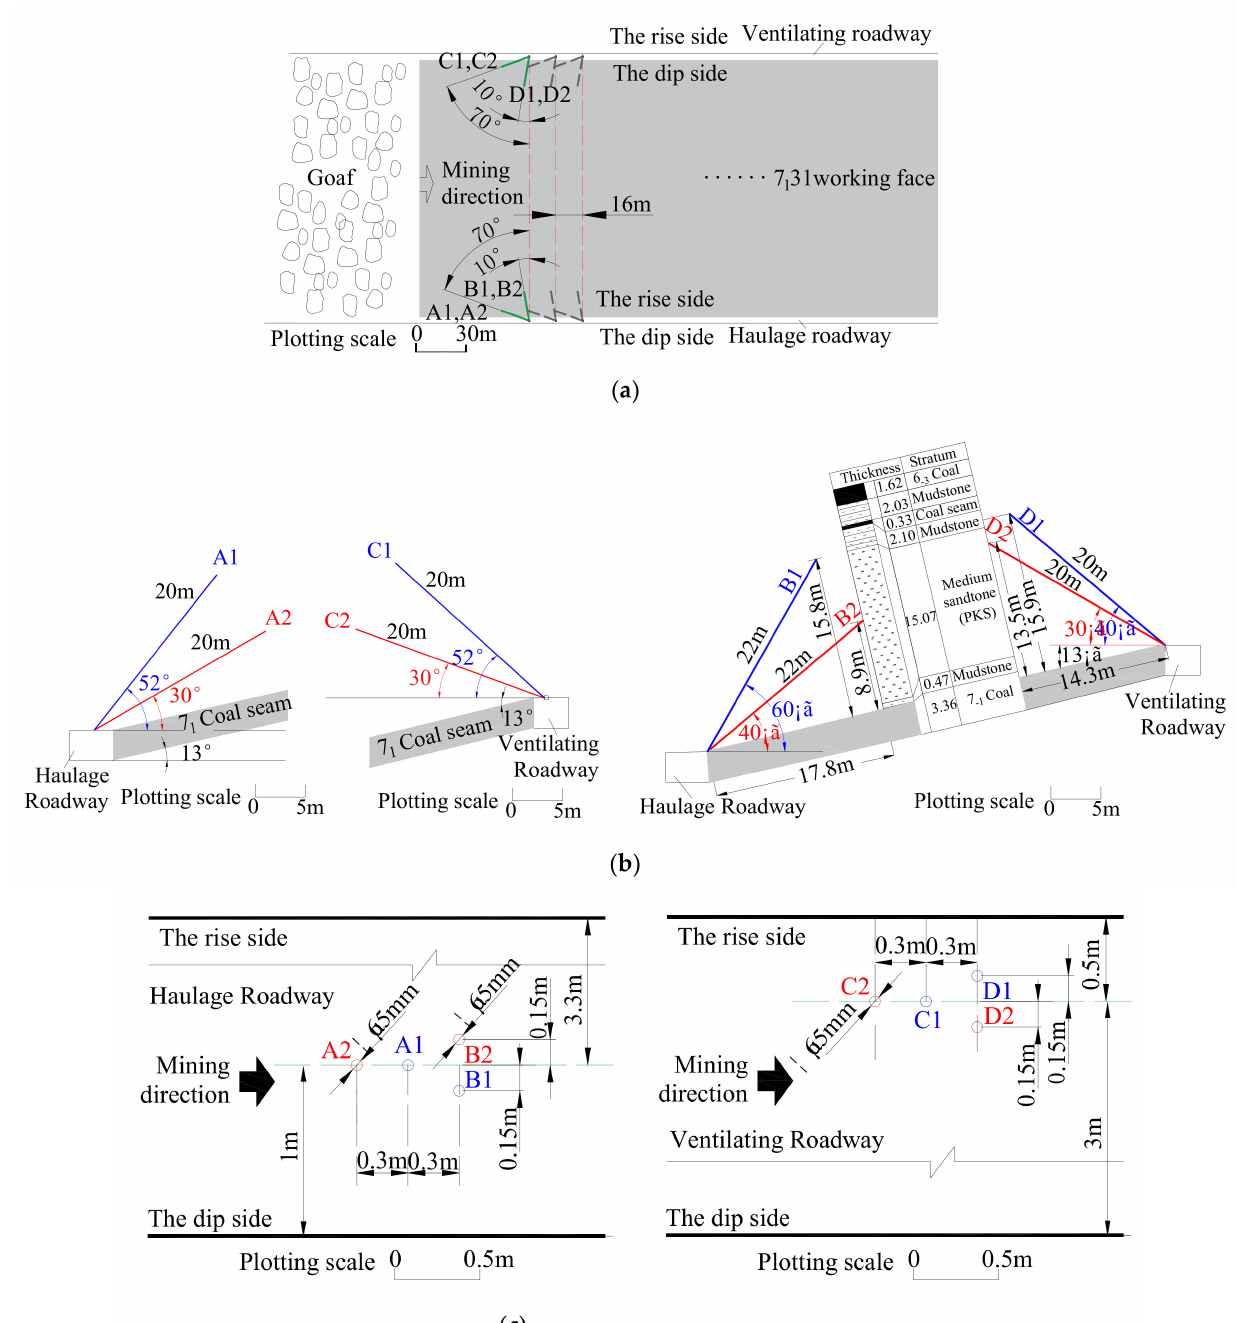
Figure 14. Design scheme of roof pre-split blasting: ( a ) plan position of pre-split blasting; ( b ) scheme of borehole; ( c ) hole location of pre-split